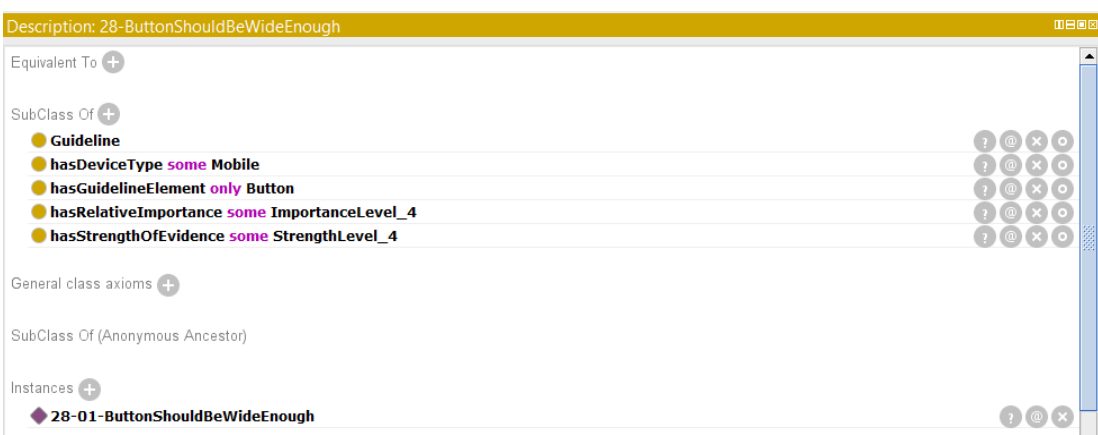
Figure 3. Example of a usability guideline concept definition for the guideline “Buttons should be wide enough” (screenshot from the Protégé ontology editor)